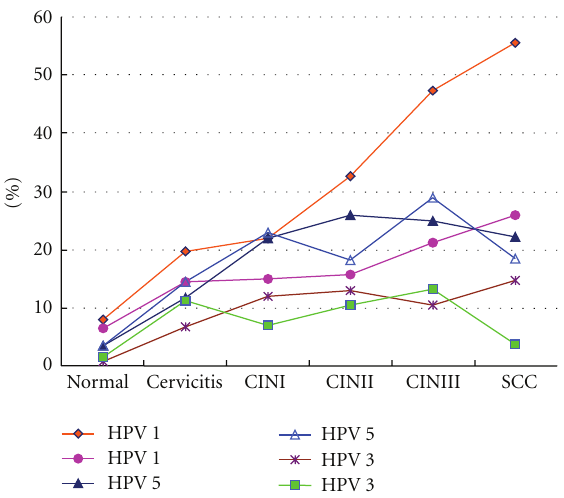
Figure 1: The positive rates of the 6 most common genotypes in di ff erent groups. It shows the positive rates of the 6 most common genotypes in di ff erent groups. CIN: cervical intraepithelial neoplasia, SCC: squamous cell carcinoma. HPV 16 was the most frequent type in almost all the groups (except for CIN I, less than HPV 58); the positive rate increased with the development of disease. Abbreviations: CIN I: cervical intraepithelial neoplasia grade I; CIN II: cervical intraepithelial neoplasia grade II; CINI III: cervical intraepithelial neoplasia grade III; SCC: squamous cell